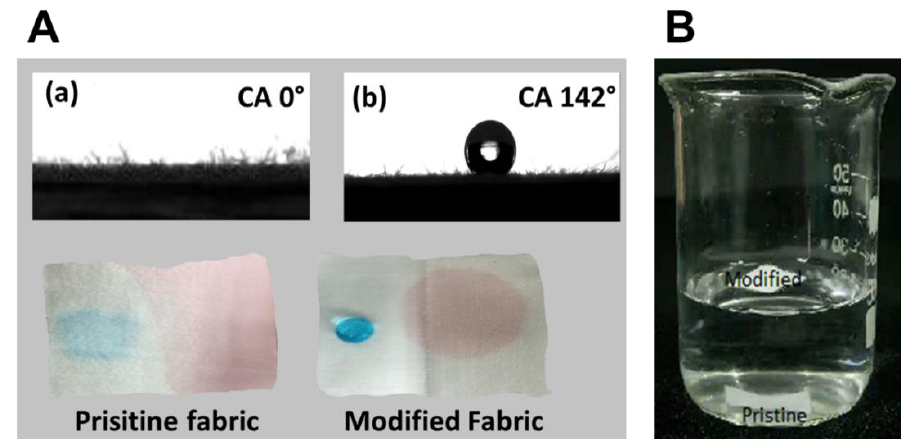
Figure 5. ( A ) Water droplet (dyed with methylene blue) and oil droplet (DCM dyed with Oil Red O) on the ( a ) pristine and ( b ) modified cotton fabric after ten washes ( B ) The modified fabric floating on the surface whereas pristine sunk.